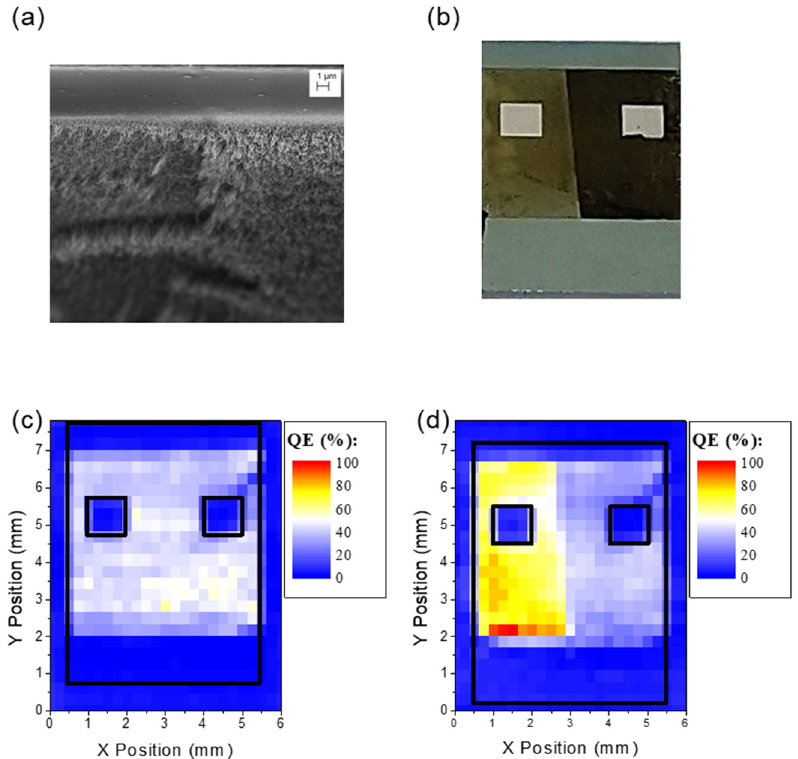
Figure 4. ( a ) SEM image of the device tilted by a 15-degree angle from the surface plane after the thinning process. ( b ) Optical image of the device after the thinning process. Quantum efficiency map of the device before ( c ) and after ( d ) MWCNT removal. The black lines mark the real dimensions of the substrate and metallic pads. Both maps were acquired using the right pad as an electrical contact.